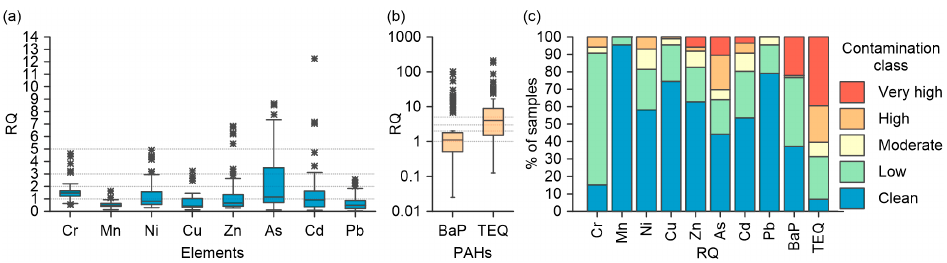
Figure 4. Boxplots of risk quotients ( RQ ) ( a ) for PTEs and ( b ) for benzo[a]pyrene (BaP) and PAHs toxic equivalent quotients ( TEQ ) in topsoils of the Lower Don floodplain and the Taganrog Bay coast; ( c ) the percentage of distribution of soil contamination classes. The boxes represent interquartile range (IQR), the line inside the box is the median, whiskers are rated as IQR *1.5, outliers (>IQR *1.5) were shown by asterisks.